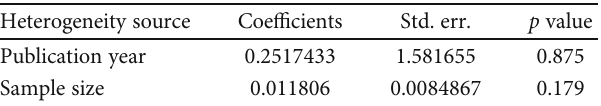
Table 3: Metaregression analysis of factors a ff ecting between-study heterogeneity of